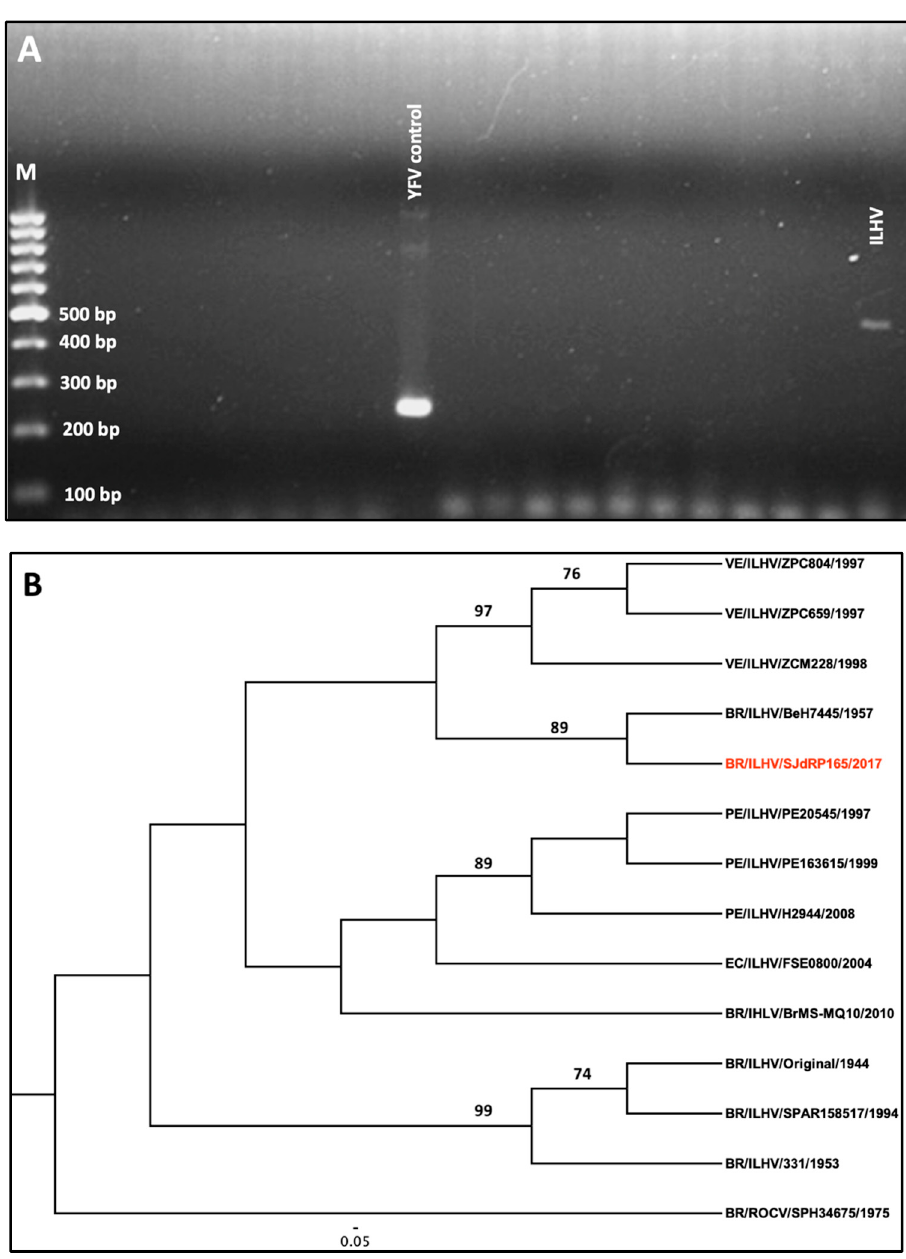
Figure 2. ( A ) Molecular detection of the Ilheus virus (ILHV) partial sequence of the NS5 gene on a 1.5% agarose gel using yellow fever virus (YFV) as a positive control. ( B ) Phylogeny of Ilheus virus inferred using the maximum likelihood method. The maximum likelihood tree was obtained from a sequence dataset of 11 isolates using a General Time Reversible (GTR) substitution model. Branches are labeled with bootstrap values that represent the percentage of 1000 replicates in which the members of a given clade were predicted to relate in the same topography. The scale shows a genetic distance of 0.05, or a 5% nucleotide sequence divergence. A homologous sequence from Rocio virus (ROCV) was used as an outgroup to root the ILHV tree. The sequence of the strain for this study is indicated in red. Abbreviations: VE – Venezuela; BR – Brazil; PE – Peru; EC – Ecuador